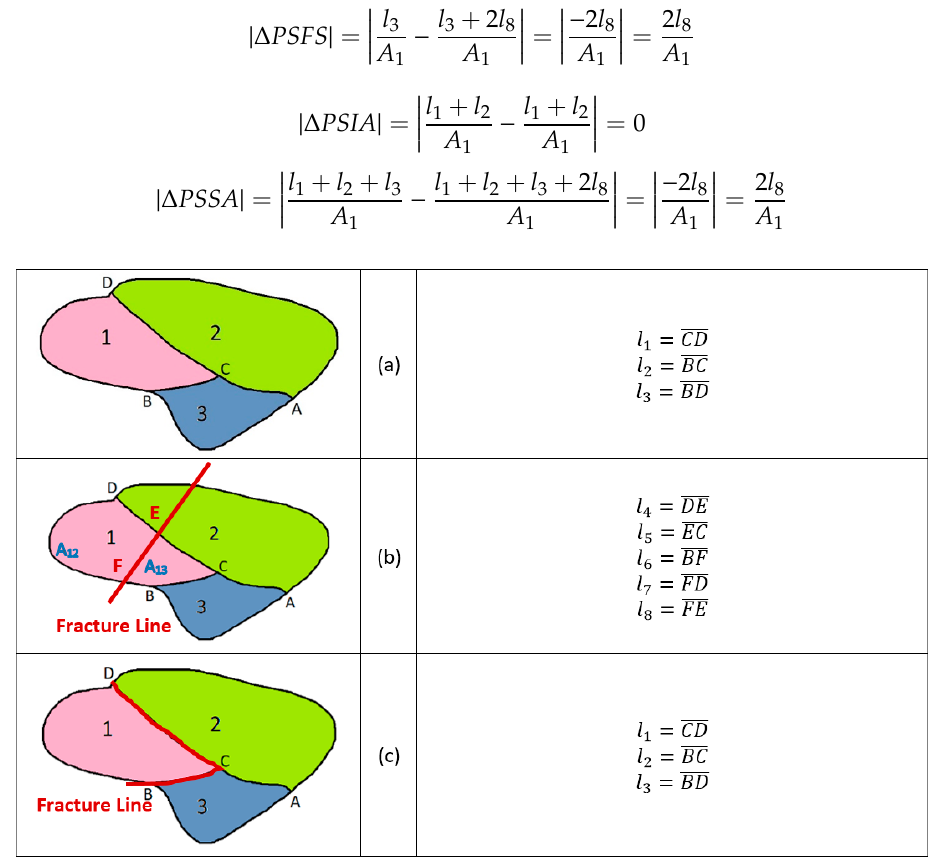
Figure 1. ( a ) A particle containing three phases with phase 1 as the valuable mineral; ( b ) transgranular breakage occurs, dividing the particle and phase 1 into two bodies; ( c ) intergranular breakage occurs, detaching phase 1.